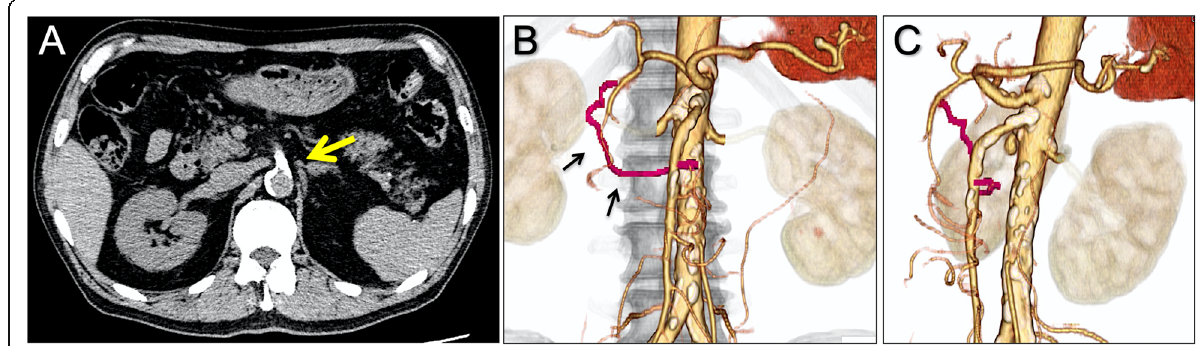
Fig. 1 Computed tomography. A , Noncontrast computed tomography (CT) revealed a heavily calcified occlusion in the ostium of the superior